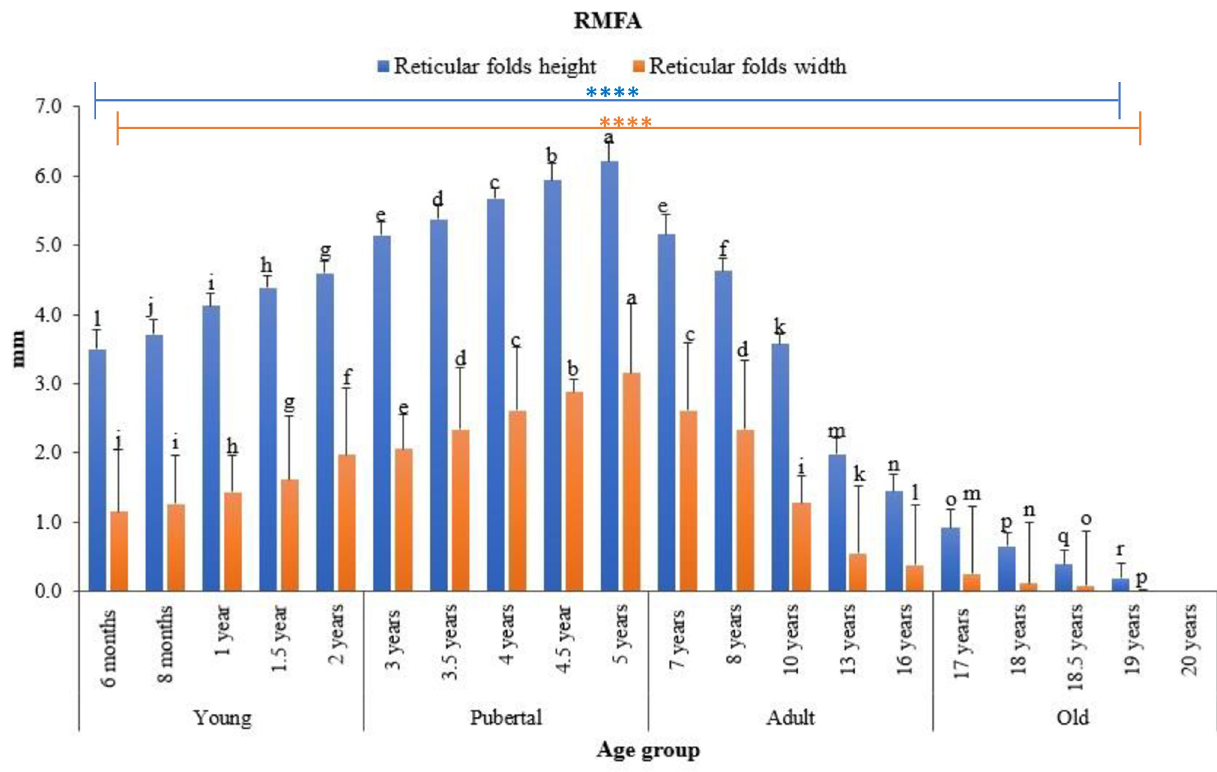
Fig 6. Differences in height and width of the reticular mucosal folds of ALNA between age groups of dromedary camels. Data are expressed as means.Error bars represent standard deviation. Bars with a different letter are significantly different (one-way ANOVA with Duncan’s multiple range test, p < 0.05). ���� represents significance at p < 0.0001. RMFA: Reticular mucosal folds